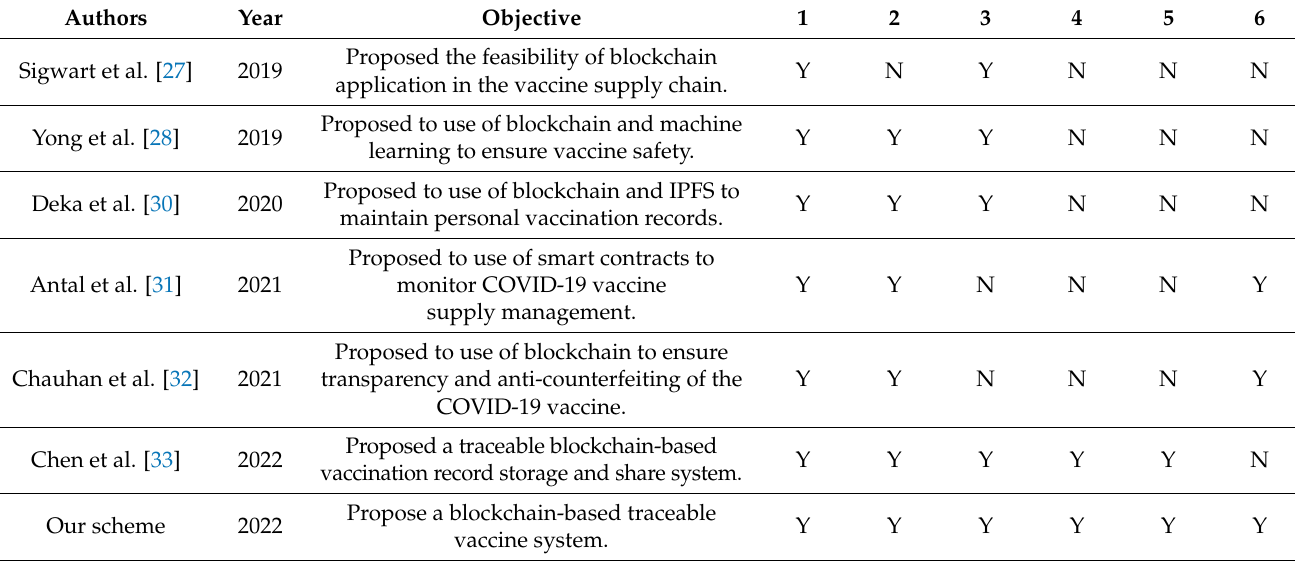
Table 3. Comparison of the proposed and other vaccine-related